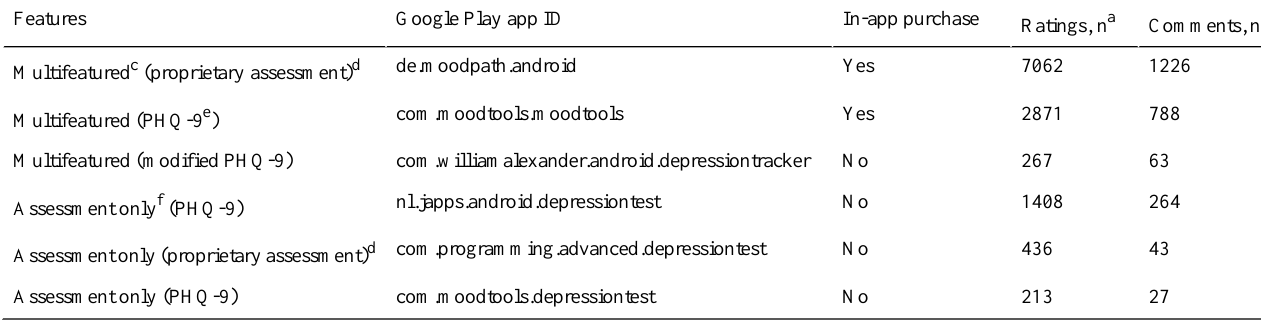
Table 1. The apps included in this